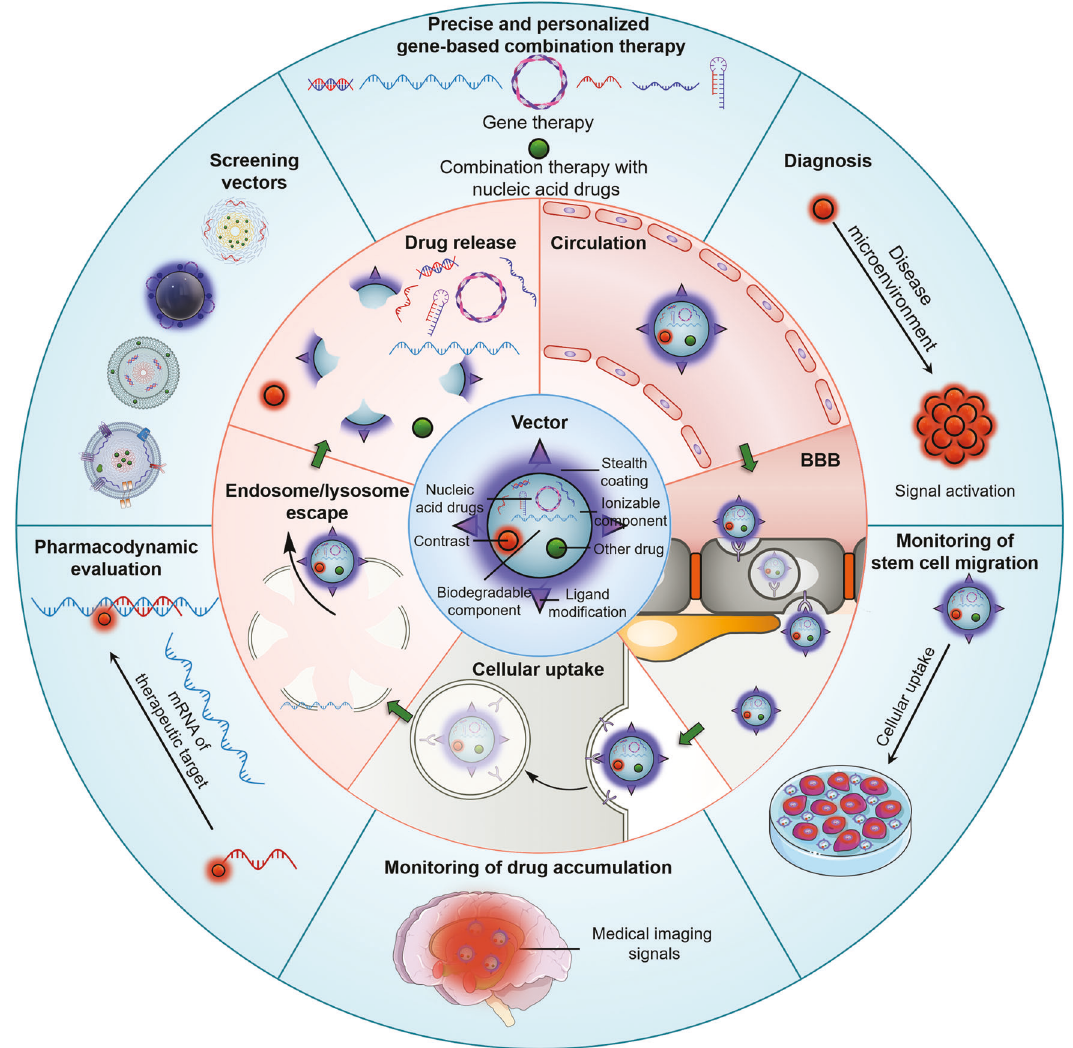
Fig. 1 Mechanisms of nucleic acid drug-based combination therapy and medical imaging contrast-based diagnosis for precise and personalized treatment of brain diseases. The inner ring shows a conventional contrast-labeled nucleic acid drug vector. The middle ring demonstrates the biological barriers that nucleic acid drug vectors face for delivery to the brain. The outer ring illustrates how medical imaging-based diagnostics contribute to precise and personalized nanotheranostics is focused on gaining more comprehensive and accurate diagnostic information through medical imaging. This Review focuses on advances in engineering vectors for brain disease diagnosis and gene therapy, with a highlight on over- coming physiological barriers to delivery through precise vector design and overcoming patient heterogeneity through accurate diagnostic information and rational therapeutic targeting (Fig. 1). In addition, this Review discusses physiological barriers to the delivery of nucleic acid drugs to the brain and generalized strategies for overcoming these barriers. In presenting nucleic acid drug vectors applied to treating brain diseases, we explore how these general- ized strategies are achieved by designing and functionalizing vectors. The Review further explores the regimen of nucleic acid drug-contained multidrug combinations for brain disease treat- ment, especially the vector design for achieving optimal multidrug ef fi cacy. Finally, this Review describes the research advances, potentials, and current limitations of integrating brain disease diagnosis and gene therapy through nanotheranostics for patient strati fi cation and personalized precision therapy and discusses perspectives for the future development of nanotheranostics.